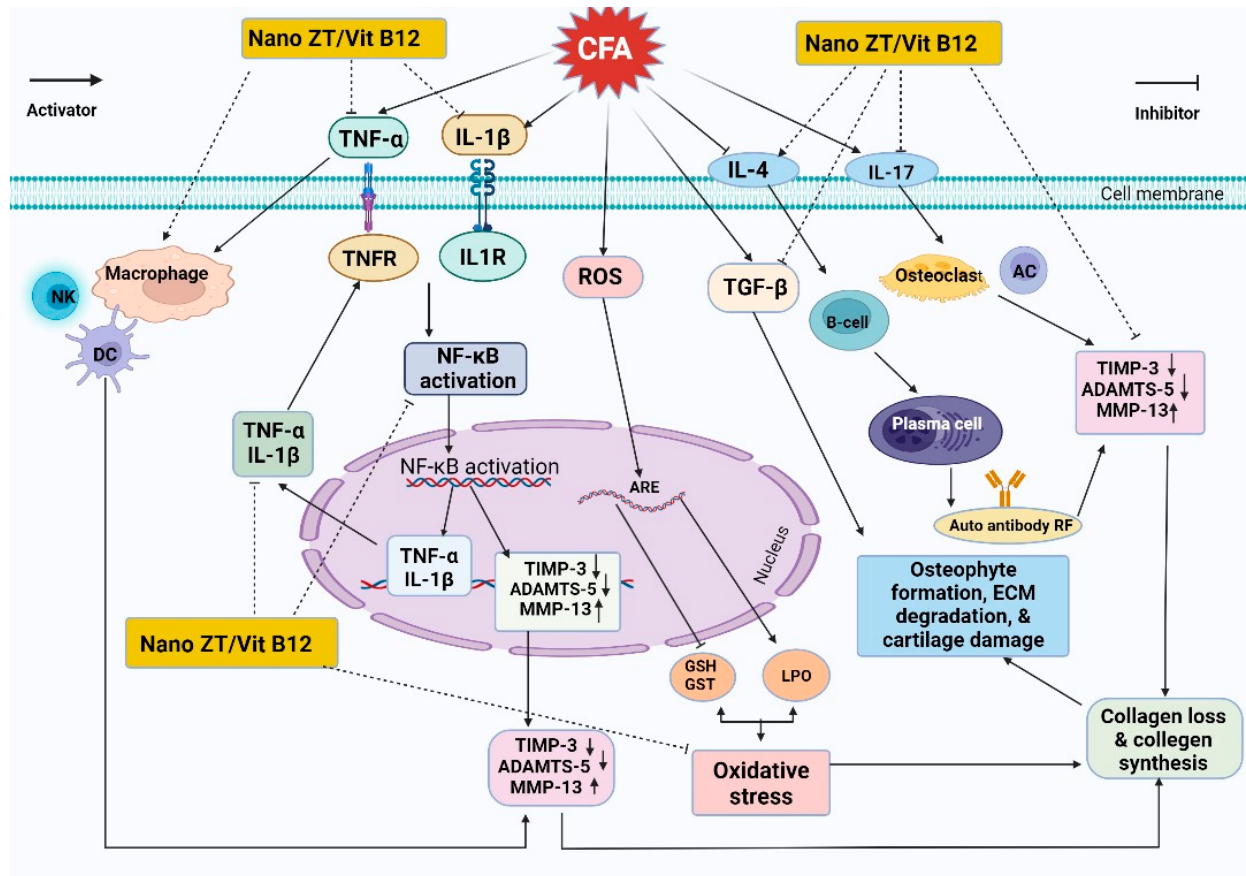
Figure 13. Schematic figure showing the mechanisms of action of Nano ZT/Vit B12 in arthritic rats.